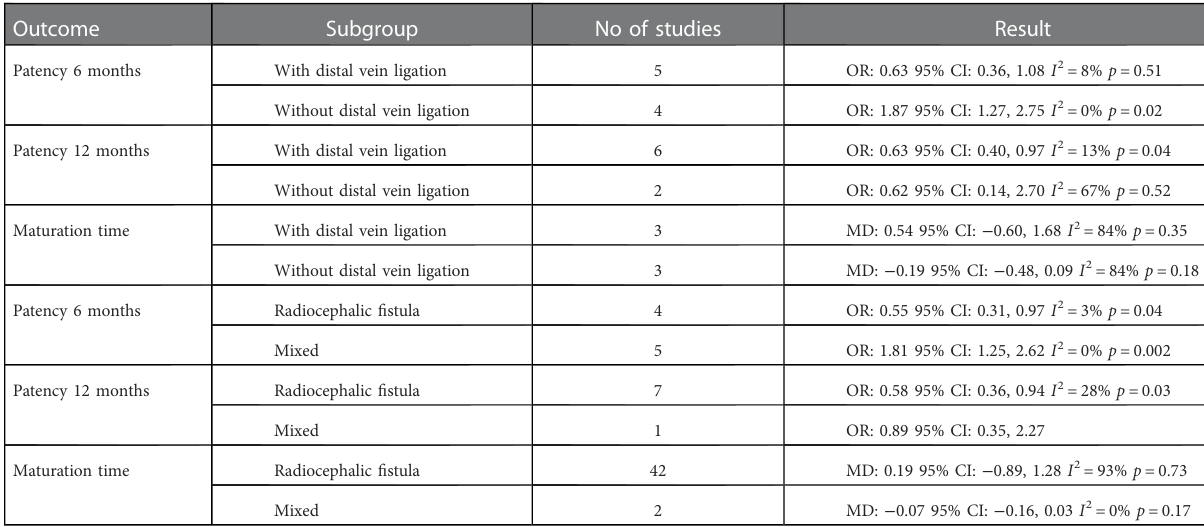
TABLE 2 Subgroup